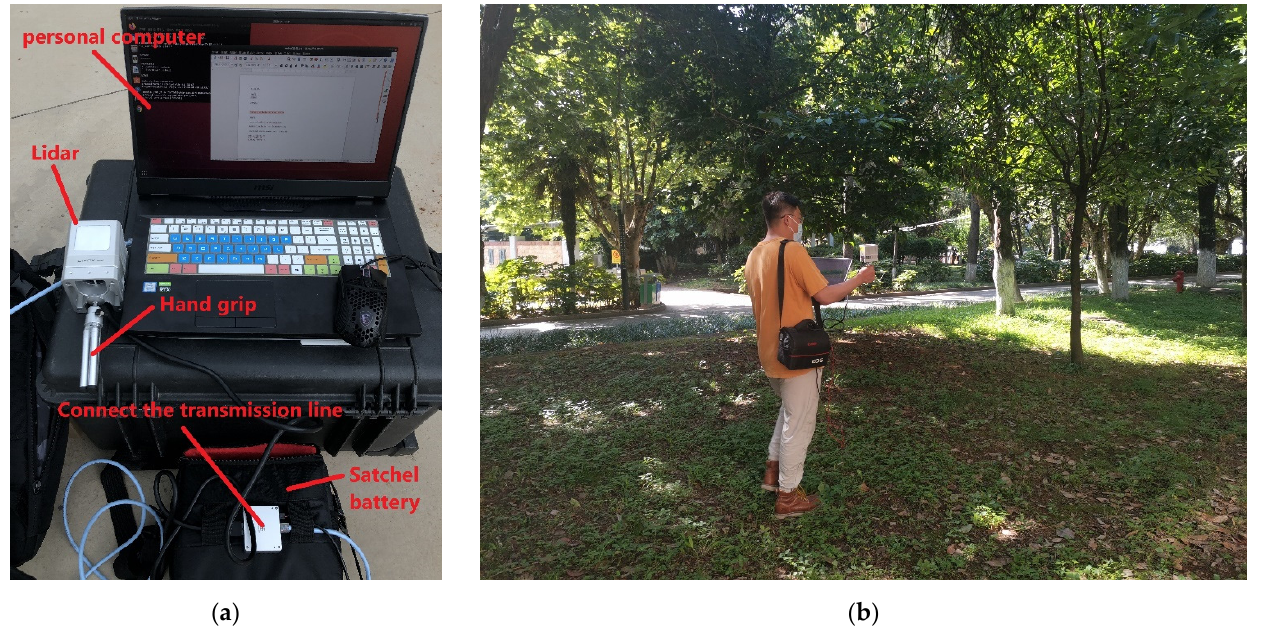
Figure 10. Equipment data acquisition diagram. (( a ) shows the handheld modified LIDAR diagram; ( b ) shows the data acquisition diagram).